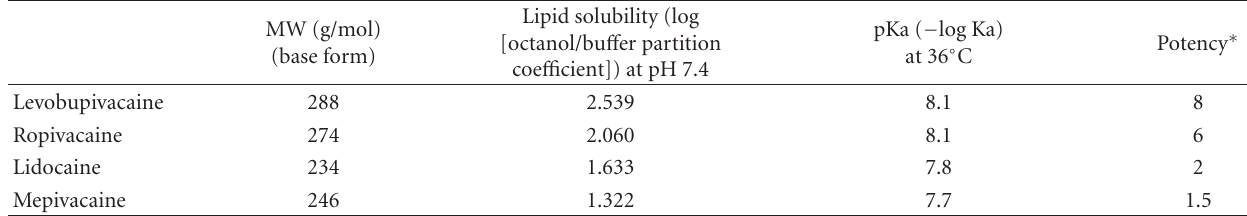
Table 1: Molecular weight, lipid solubility, pKa, and potency of local anesthetics [3,